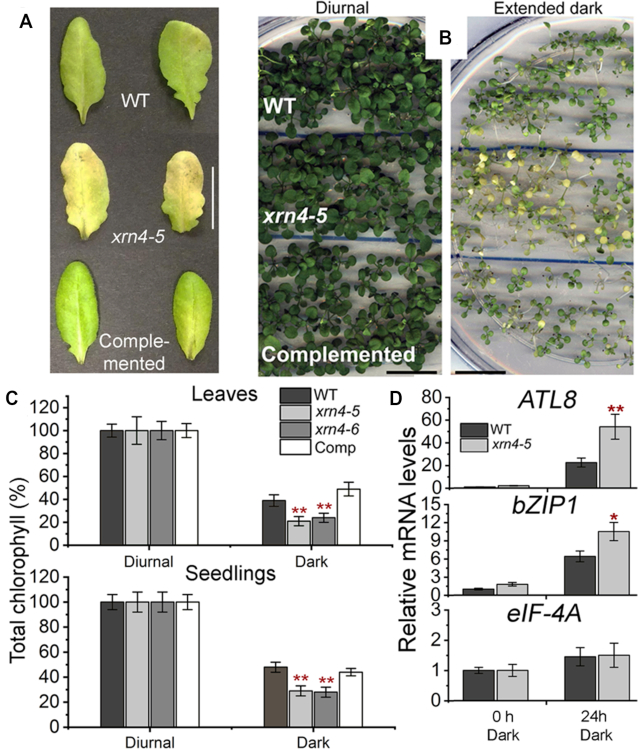

xrn4 is oversensitive to dark treatment of leaves and seedlings. Detached leaves (A) and intact seedlings (B) of WT, xrn4–5 and complemented line of xrn4–5 (Comp) after extended dark (A, 4 d and B, 12 d) treatments; scale bar, 20 mm. (C) Chlorophyll content of dark treated (leaves, 4 d and seedlings, 12 d) WT, xrn4–5, xrn4–6 and Comp presented as a percentage of diurnal (100%). Histograms are means from three biological replicates; four leaves from a total of 12 plants per genotype per condition (A) and a total of 15 pools of seedlings (5 to 6 plants per pool) per genotype per condition (B) were assayed and presented as percentages ± standard error of the mean (SEM). (D) Quantitative RT-PCR of polyA+ RNA show mRNA levels of ATL8, bZIP1 and eIF-4A (control transcript) in 2-week-old seedlings of WT and xrn4–5 after 0 h and 24 h of dark treatment. WT levels at 0 h set to 1. Data are means ± standard deviation (SD) from four biological replicates; **, P< 0.01 and *, P< 0.05.